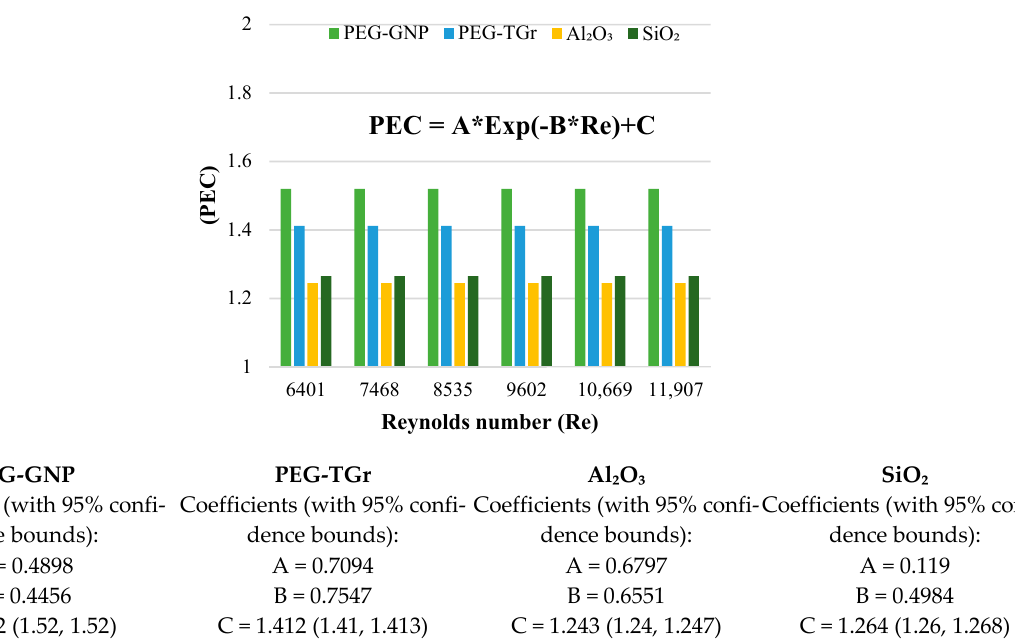
Figure 9. PI against different nanofluids and Reynolds number.